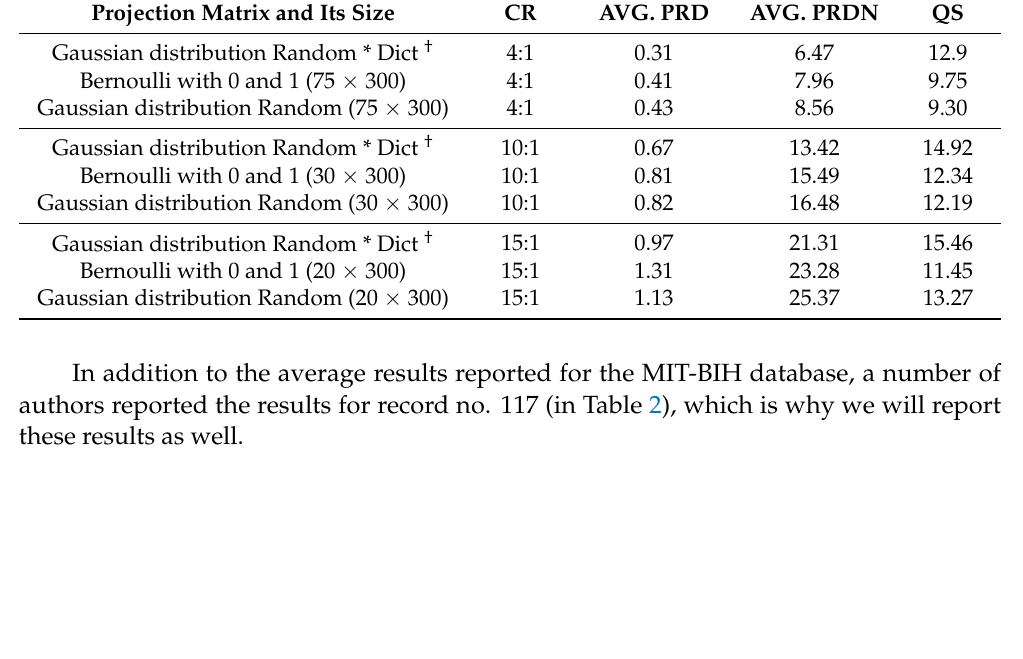
Table 1. Average results for 24 ECG records processed with the PSCCS method. Projection Matrix and Its